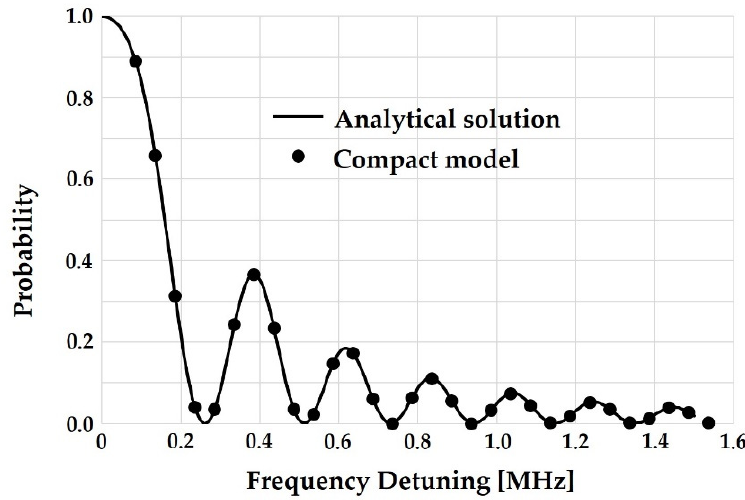
Figure 6. A 35-kHz frequency compensated simulated chevron cross-section vs. analytical chevron cross-section for P 0 for the first peak of the Rabi oscillation ( τ p = 1.689 μ s) in the case of trapezoidal integration method.